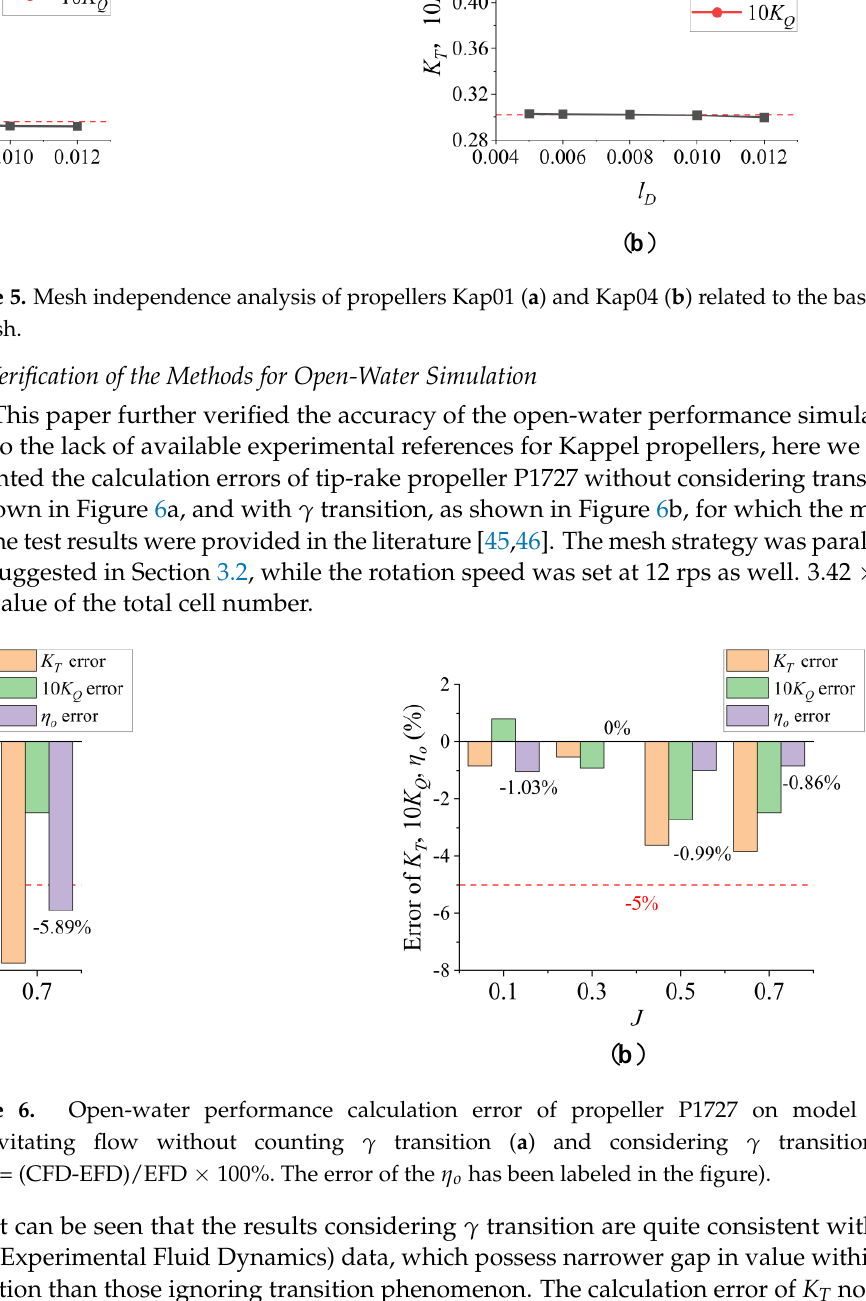
( c ) Figure 7. Streamline distribution on suction side surface of propeller Kap00 ( a ), Kap02 ( b ) and Kap04 ( c ) ( J = 0.8, 12 rps). ( a )